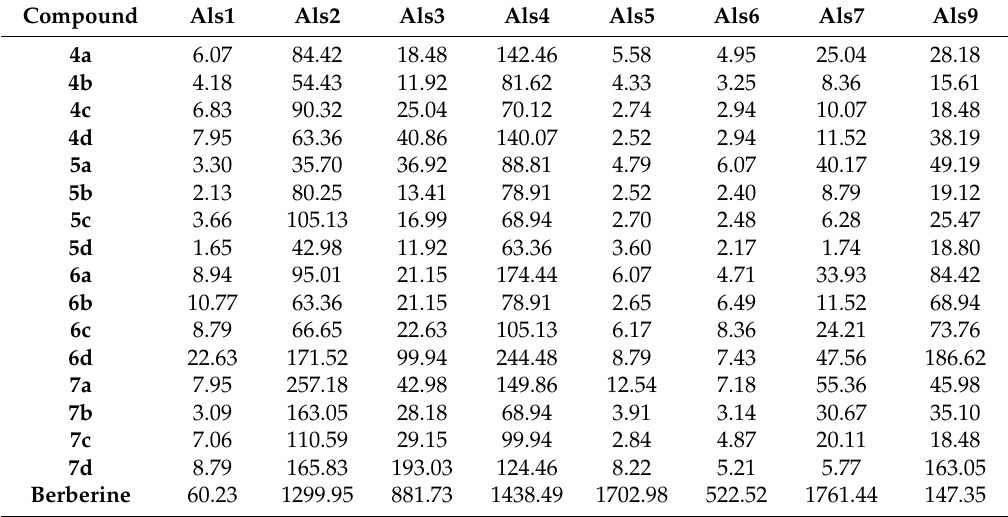
Table 6. The predicted inhibition constants Ki (nM) for the tested compounds-Als complexes.